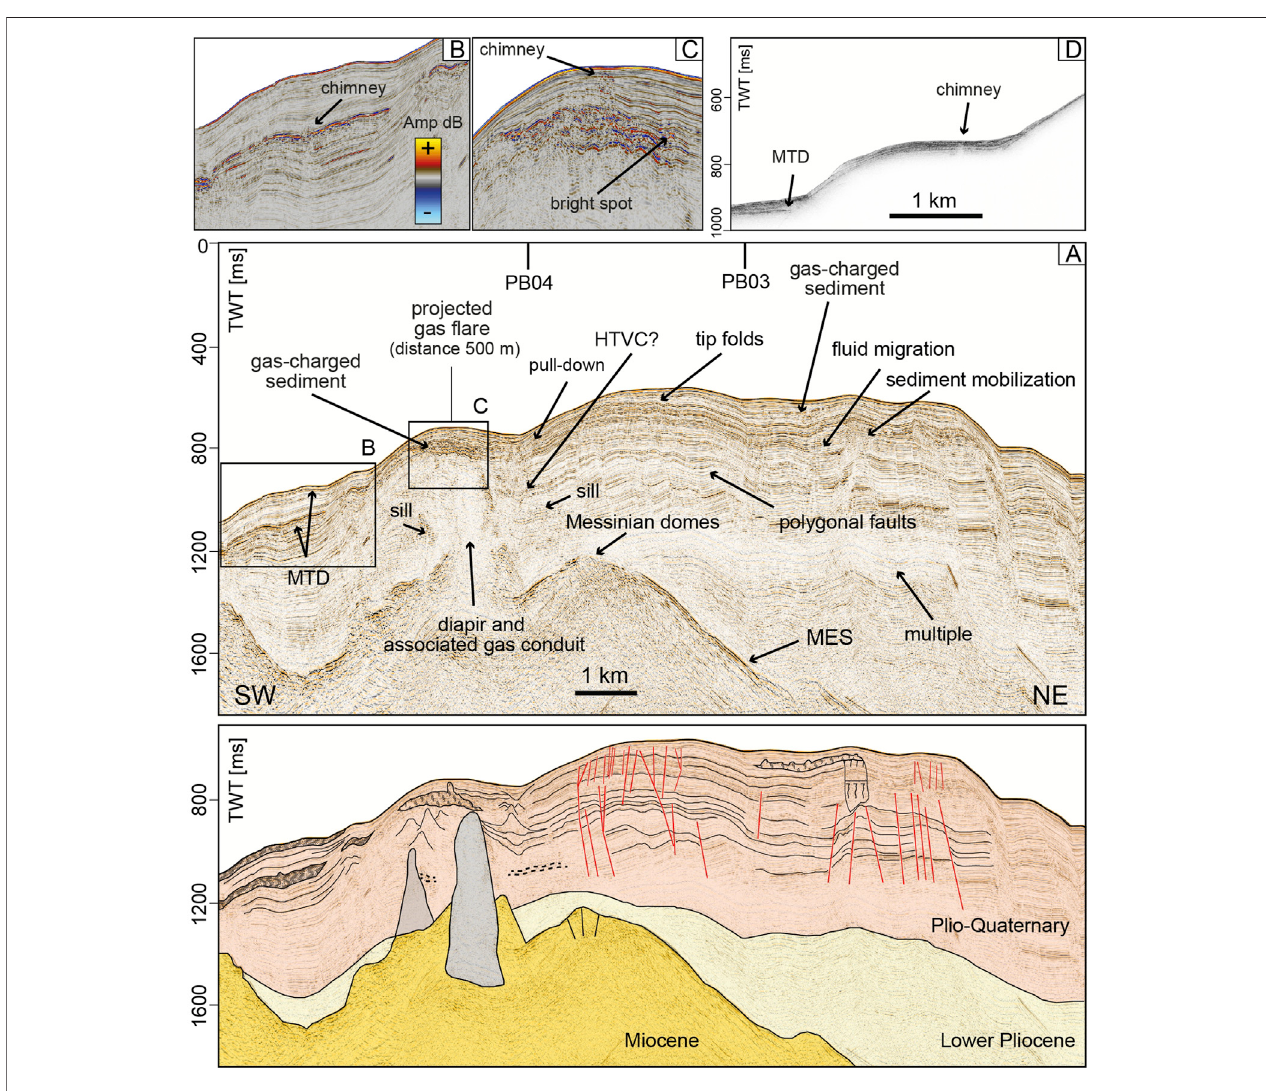
FIGURE 5 | (A) Seismic re fl ection pro fi le PB01 and its line drawing (lower panel), showing the diapirism of the Messinian units below a projected gas fl are in the water column. Close-up panels of seismics showing: (B) a chimney above an MTD; (C) a chimney emanating from bright spots located 50 m below the seabed. (D) CHIRP seismic pro fi le showing the high amplitude character of the shallow re fl ections, a gas chimney and a shallow-seated MTD. Locations in Figure 2A .